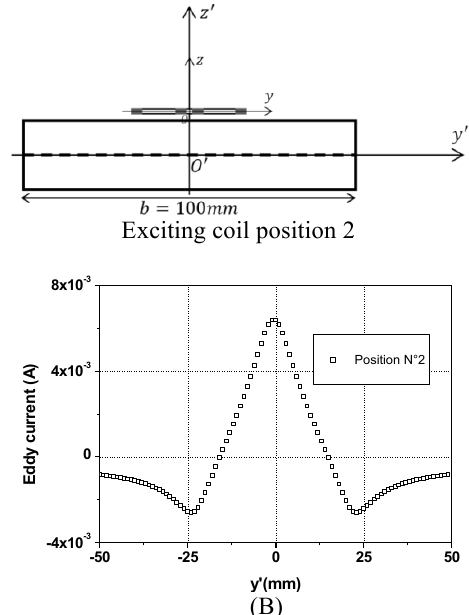
Figure 6 (B): Induced currents corresponding to the case of exciting coil position 2 as shown in the previous figure